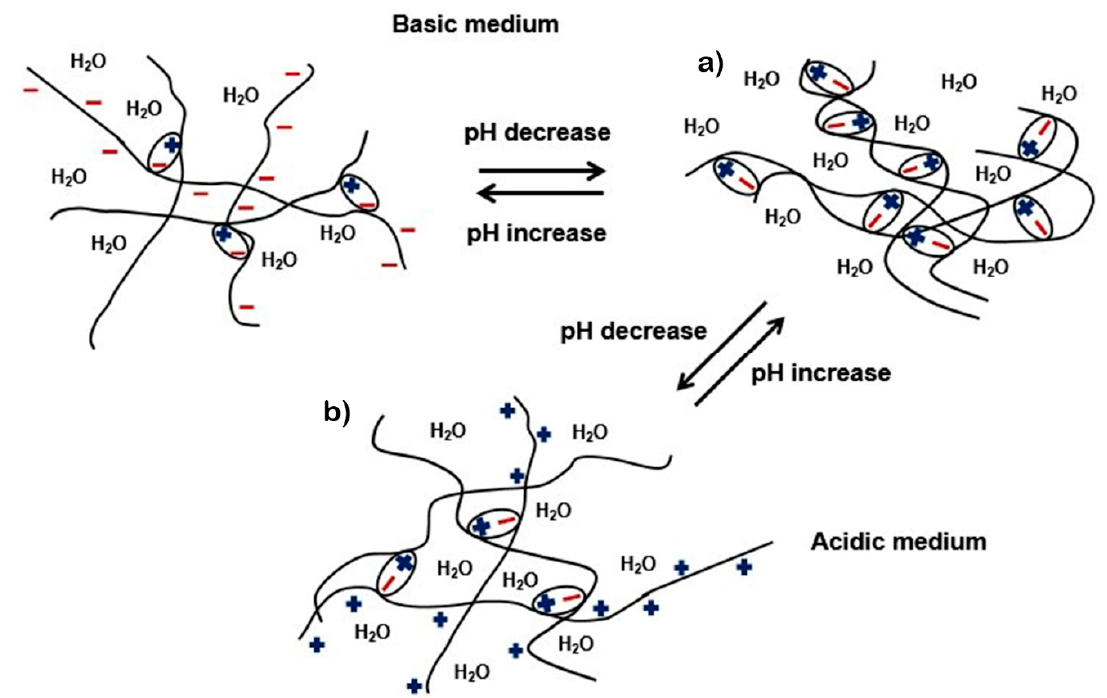
Figure 8. Polymer chains under different pH values: ( a ) pH 7.0; ( b ) pH 4.0 [15].